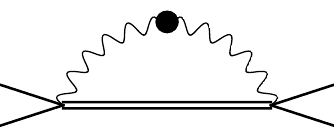
Figure 2 . Illustration of the generalized cross section eq. (2.11) in terms of a self-energy diagram, containing the interacting mediator two-point function. Parallel lines represent the bound state, while open lines correspond to the two-particle scattering